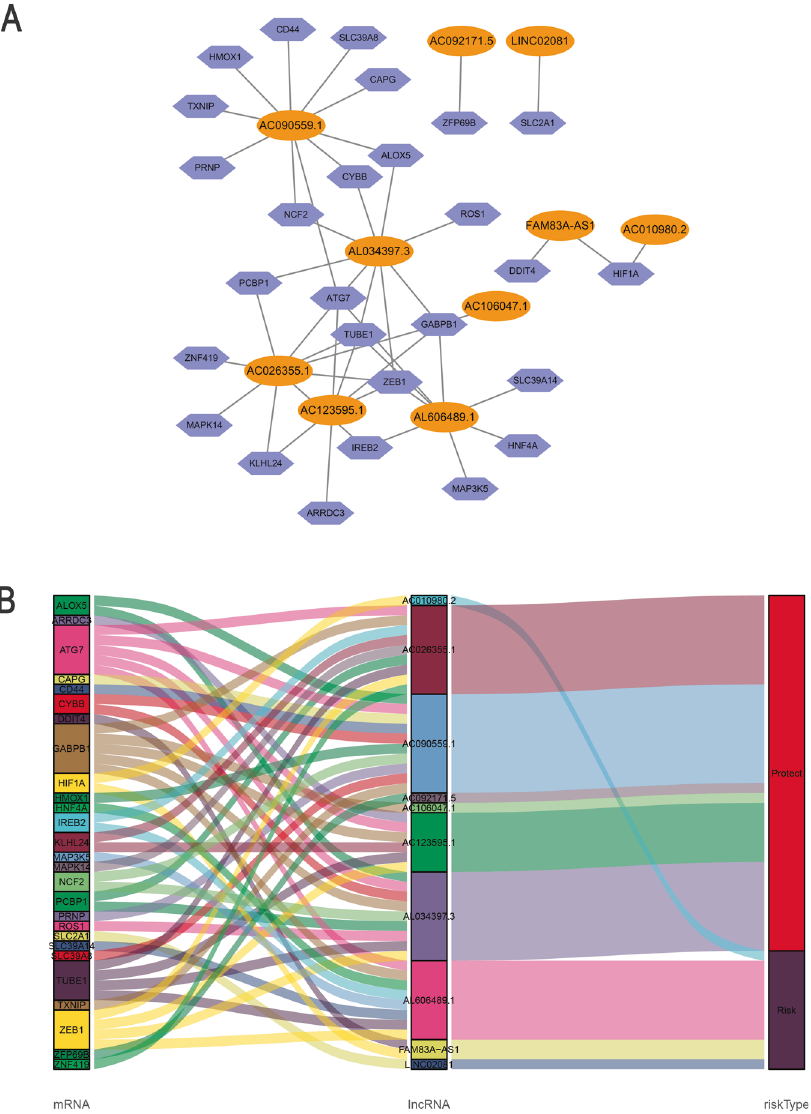
Fig. 2 Coexpression network and Sankey diagram of prognostic ferroptosis-related lncRNAs. A A coexpression network of ferroptosis- related lncRNAs and mRNAs was constructed and visualized using Cytoscape. Orange ellipses indicate prognostic lncRNAs, and blue violet diamonds indicate ferroptosis-related mRNAs. The levels of the 10 ferroptosis-related lncRNAs were associated with the levels of 27 ferroptosis mRNAs. B Sankey diagram showing the associations between prognostic ferroptosis-related lncRNAs, mRNAs, and risk